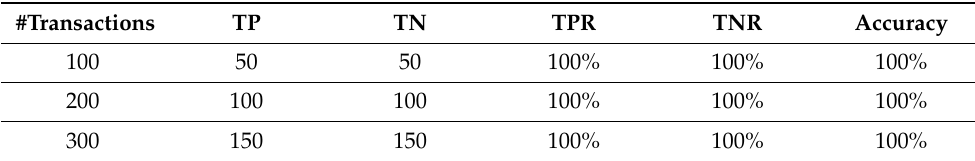
Table 7. TPR, TNR, and Accuracy of PoST protocol in verifying satellites